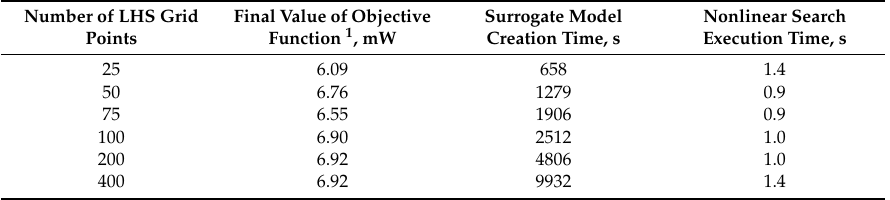
Table 1. Results of optimization using Strategy I.